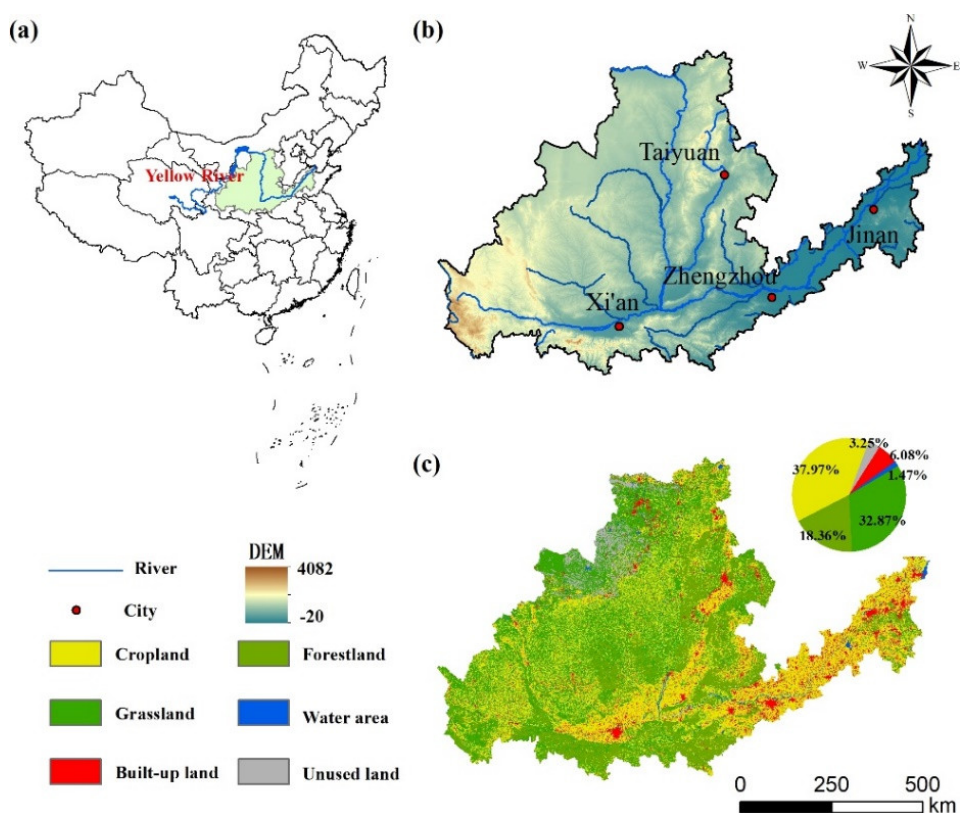
Figure 1. ( a – c ) Location, elevation, and 2018 land use of the study area.